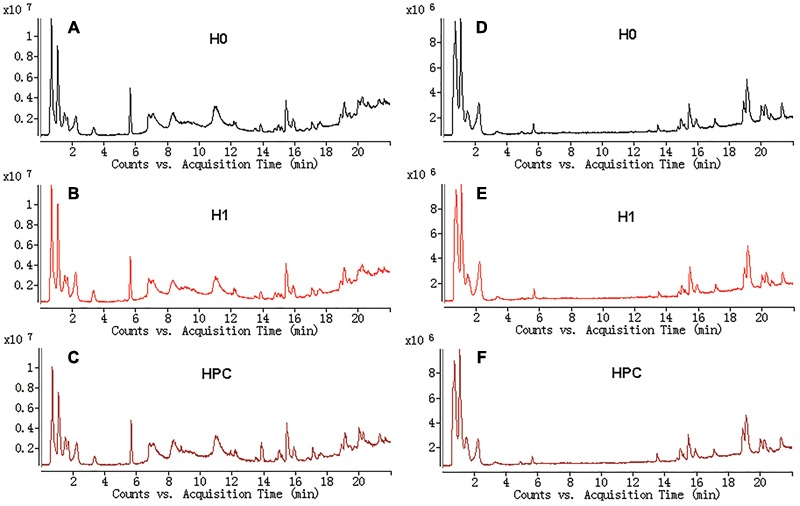
Typical total ions current chromatograms from hippocampus samples separated on LC ESI+
(A–C) and LC ESI-
(D–F).